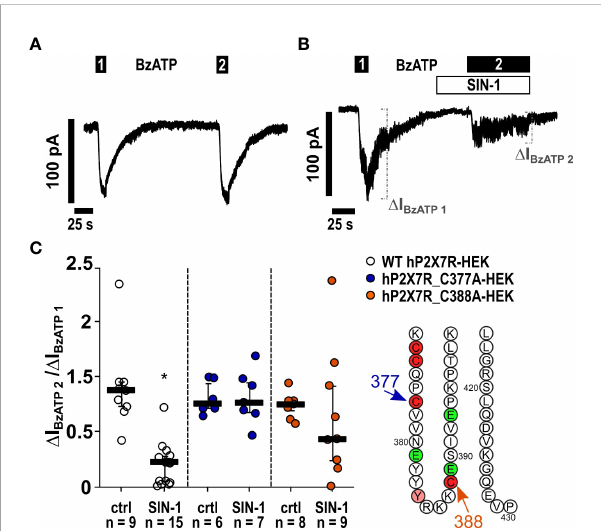
FIGURE 7 The NO and peroxynitrite donor SIN-1 inhibits the BzATP-induced ion channel functions in human P2X7 receptor (hP2X7R) expressing HEK cells via the cysteine C377 in the C-terminal intracellular loop. (A, B) Depicted are representative current curves of whole-cell patch-clamp measurements. (A, C) In control experiments (ctrl) on human wild- type (WT) P2X7R expressing HEK cells (WT hP2X7-HEK), consecutive application of the P2X7R agonist BzATP (100 µM) induced repetitive ion current stimulations (BzATP1 and 2). (B, C) In the presence of SIN- 1 (1 mM), the BzATP-induced ion current was blunted. (C) Similar experiments were performed on HEK cells expressing hP2X7R mutants generated by replacing cysteine 377 or 388 by an alanine (hP2X7_C377A; hP2X7_C388A) in the C-terminal intracellular loop. The BzATP-induced current changes ( D I BzATP1 , D I BzATP2 ) were normalized ( D I BzATP2 / D I BzATP1 ). (C) All BzATP-induced current changes ( D I BzATP ) are shown as individual data points, bars represent